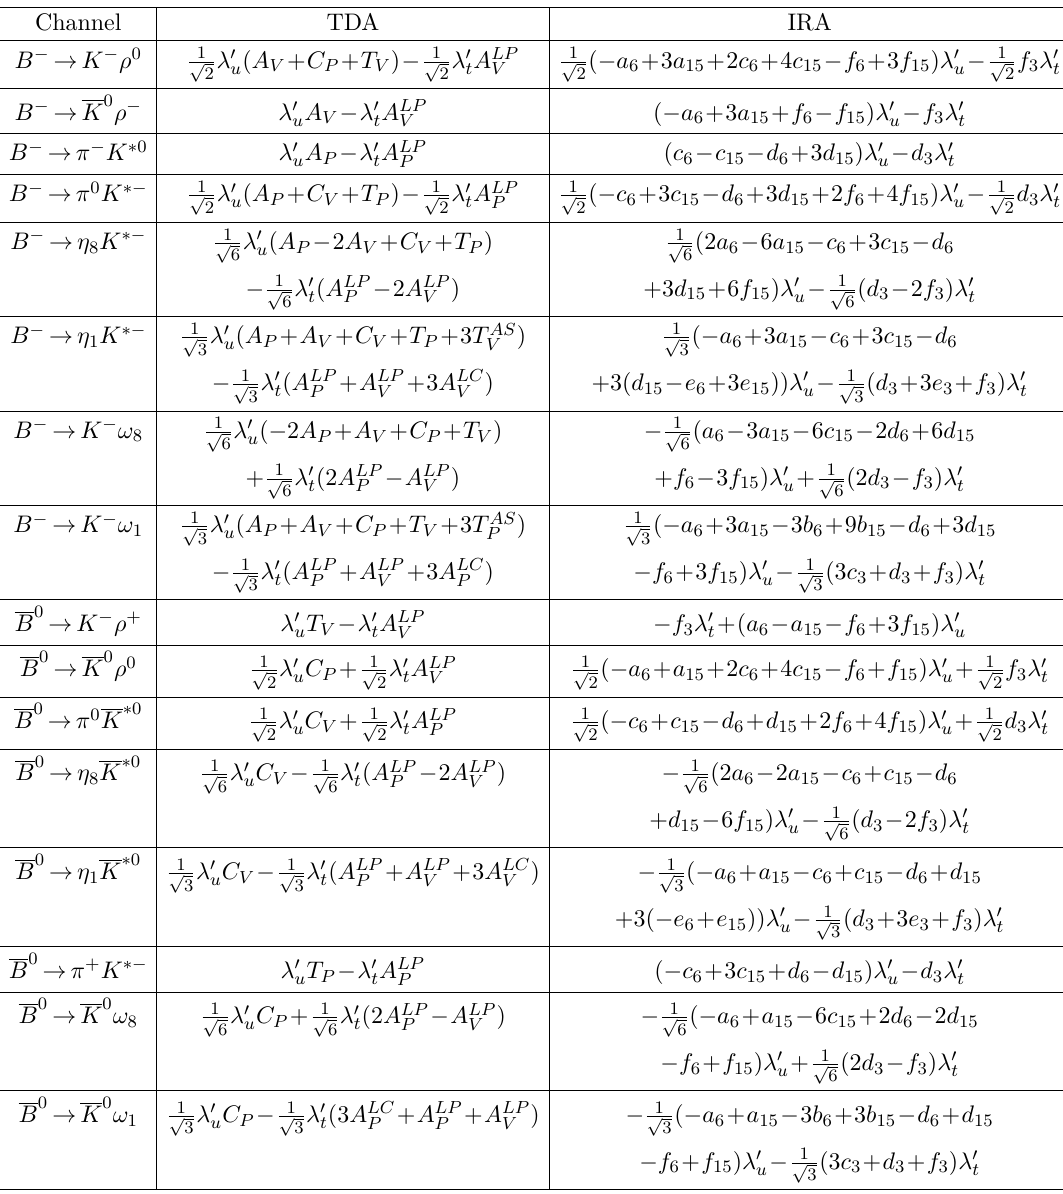
Table 10 . Decay amplitudes of the B u,d → PV decays induced by the b → s